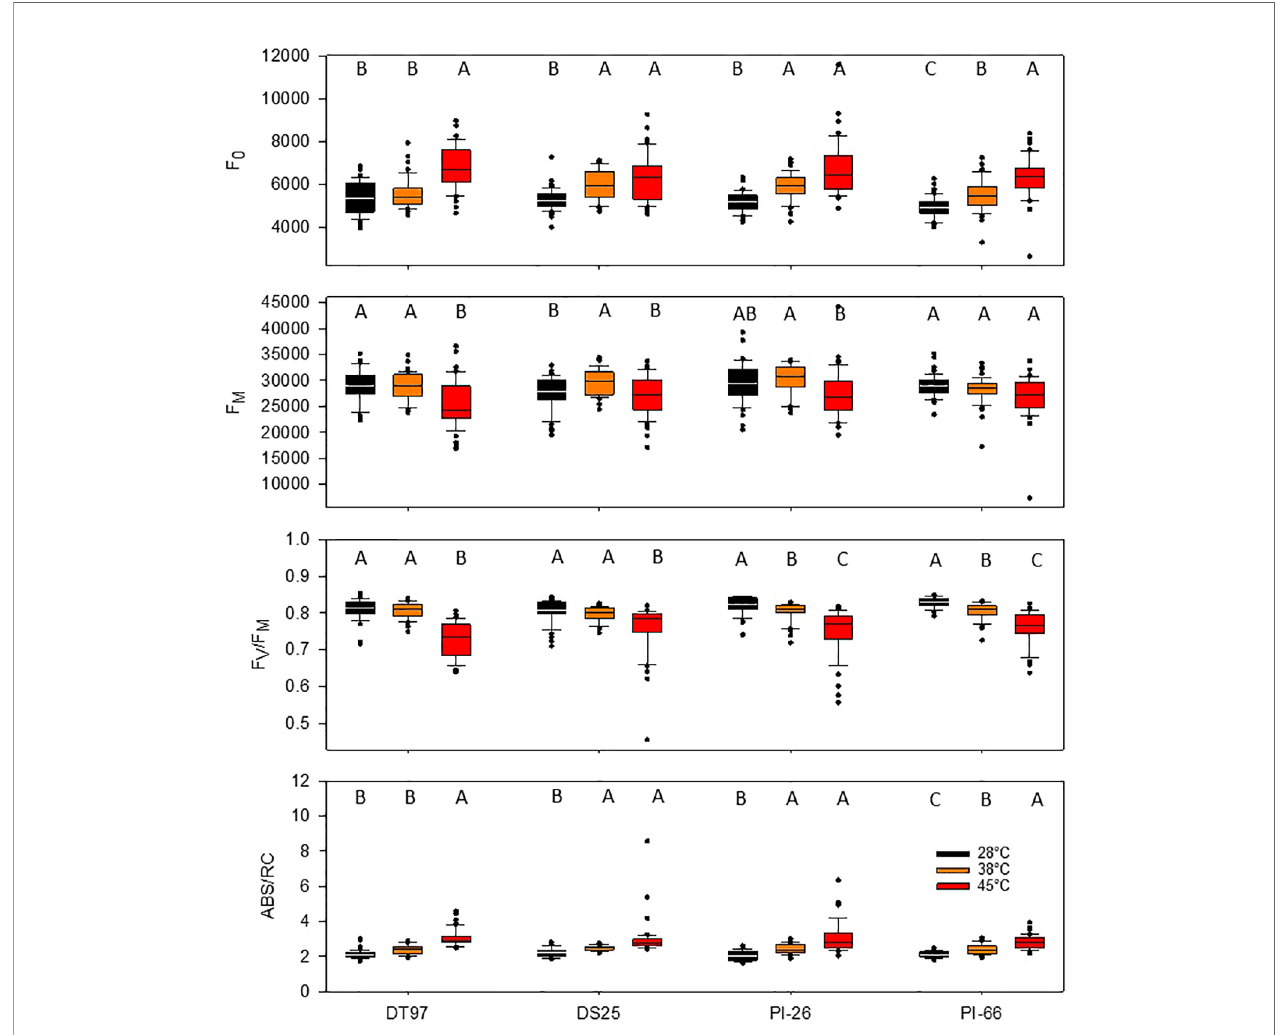
FIGURE 2 | Minimum fl uorescence (F 0 ), maximum fl uorescence (F M ), maximum photochemical ef fi ciency (F V /F M ), and absorption per reaction center (ABS/RC) of four soybean genotypes exposed to maximum day time temperatures of 28, 38, and 45°C over the course of 7 days. Data represents chlorophyll fl uorescence measurements on the center lea fl et of the upper-most fully expanded leaf after 1 h of temperature treatment on days 1, 3, 5, and 7 from two independent growth chamber experiments for each temperature treatment (N = 48). Lines within boxes represent the median and top and bottom of whiskers represent the 1 st and 3 rd quartiles respectively. Circles represent outlier data one and a half times the 1 st and 3 rd quartiles. Letters indicate similar treatments of phenotypes within genotype based on Tukey pairwise